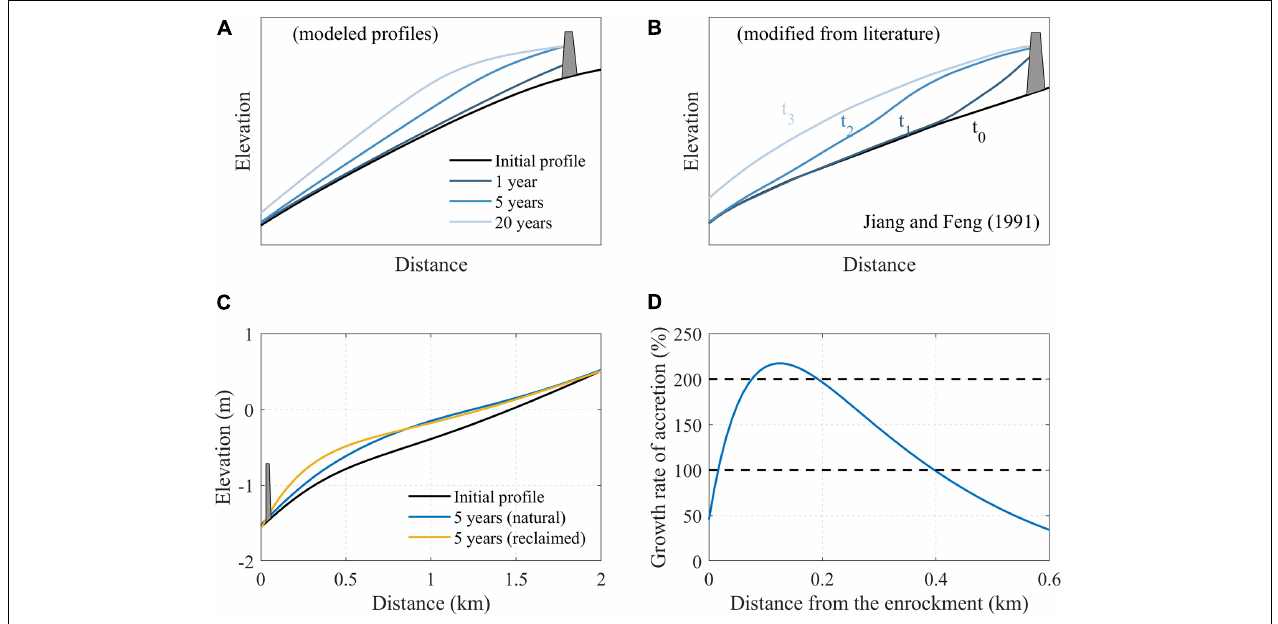
FIGURE 2 | Comparison of model results against previous studies. (A) Simulated tidal flat profiles after enclosure, starting from a convex equilibrium profile. (B) Distinct stages (t 0 –t 3 ) in the adjustment of tidal flat after enclosure, modified from Jiang and Feng (1991). (C) Simulated profiles under natural state and after enrockment. (D) The effect of enrockment in (C) on enhancing accretion rate, computed by ( v r - v n )/ v n where v n and v r are the vertical accretion rates on natural and reclaimed tidal flats, respectively. Note that (D) only focuses on the region near the